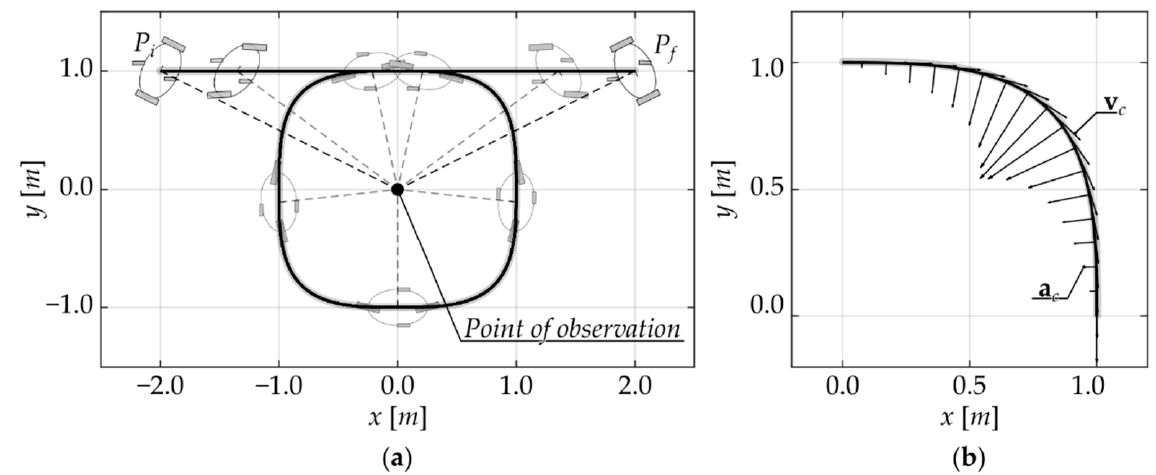
Figure 7. Use case simulation 1: curved path definition ( a ) qualitative representation of the accelerations and ( b ) velocities obtained in the curved sections.